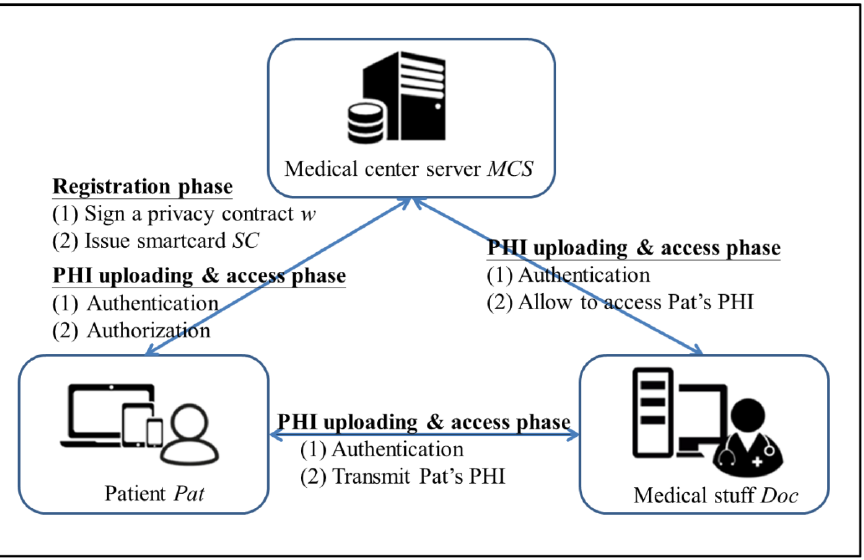
Figure 1. The relations between Pat , Doc and MCS in the medical system model. The MCS pro- vides Pat and Doc with registration. Pat needs to sign a privacy contract with MCS . Pat and Doc store and exchange protected PHI via the help of MCS